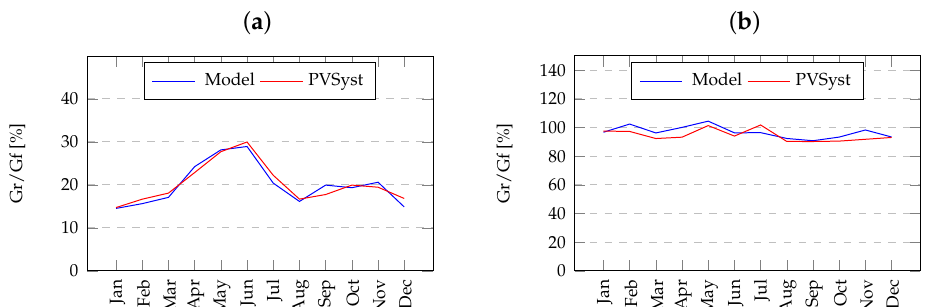
Figure 12. Estimated model comparison vs. the PVSyst Gr/Gf % gain from Jan to Dec for the ( a ) tilted SN orientation and ( b ) vertical EW orientation, Location—Ahmedabad.